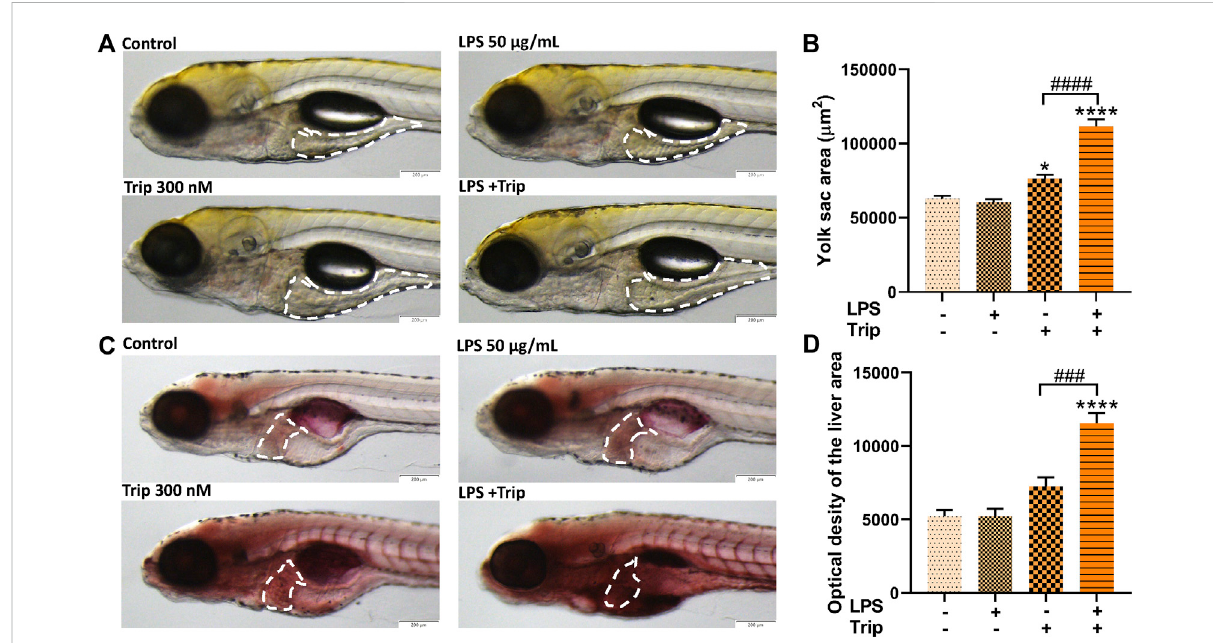
FIGURE 4 Theeffectoftriptolideonlipidmetabolisminzebra fi shinanin fl ammatorystate. (A) Changesinyolksacofzebra fi sh,yolksacwereoutlinedwith white dotted lines. (B) Zebra fi sh yolk sac area. (C) Oil red O staining, liver was outlined with white dotted lines. (D) Oil red O staining quanti fi cation. * p < 0.05, **** p < 0.0001 vs. the blank control group. ### p < 0.001, #### p < 0.0001 vs. the Triptolide (Trip)